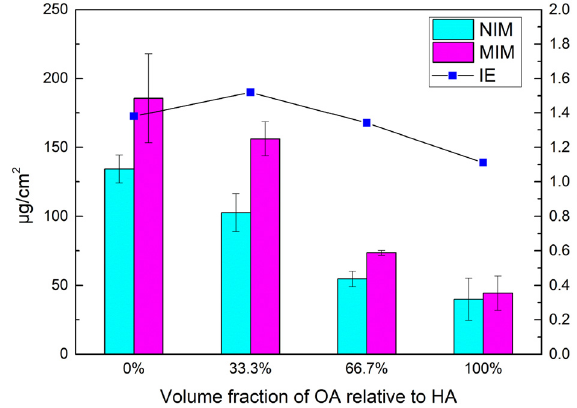
Figure 14: Adsorption capacities and imprinting e ffi ciency of dif - ferent volume fractions of OA relative